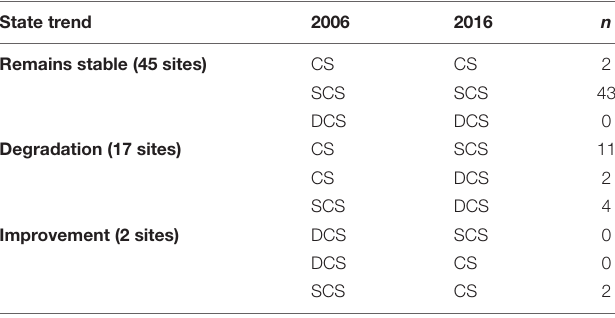
TABLE 1 | Summary of state trends between 2006 and 2016 and the number of sites belonging to each trend.